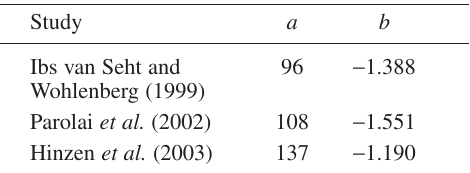
Table I. Different model parameters for the empiri- cal relation between peak frequency and depth of the dominant seismic contrast.